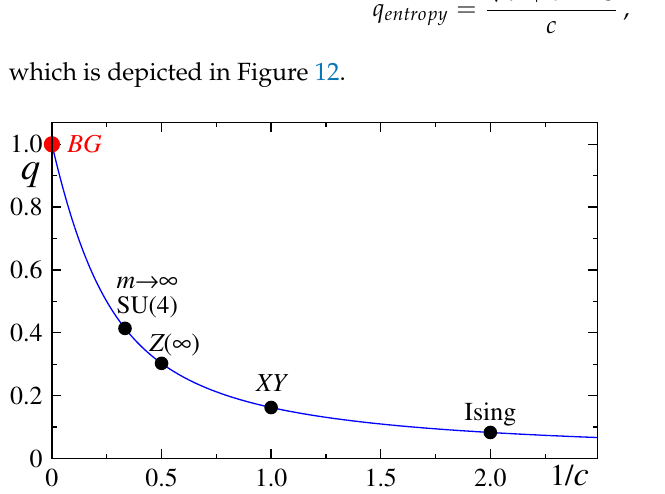
Figure 12. The index q entropy as a function of the inverse central charge 1/ c . The universality classes of some specific models are indicated, see [94]. The BG value q entropy = 1 is recovered in the c → ∞